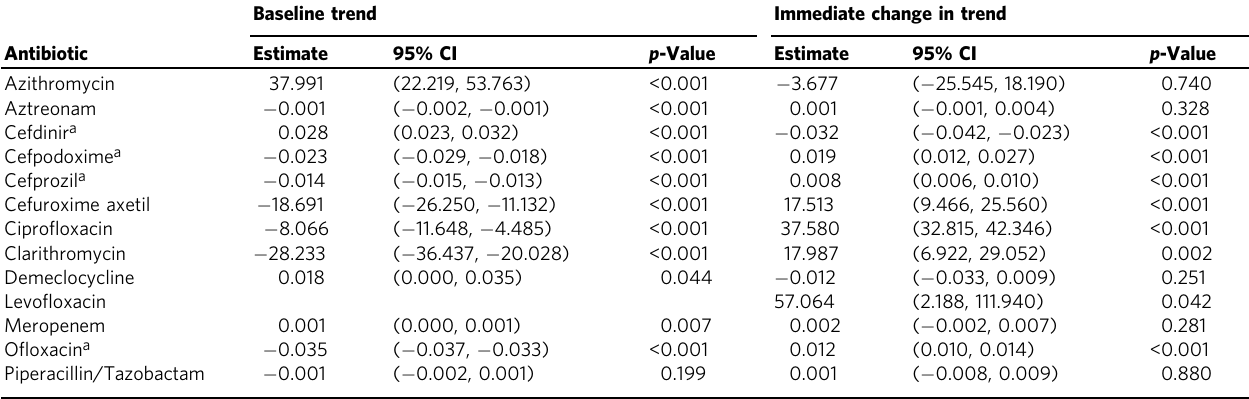
Table 1 Trends before and after generic